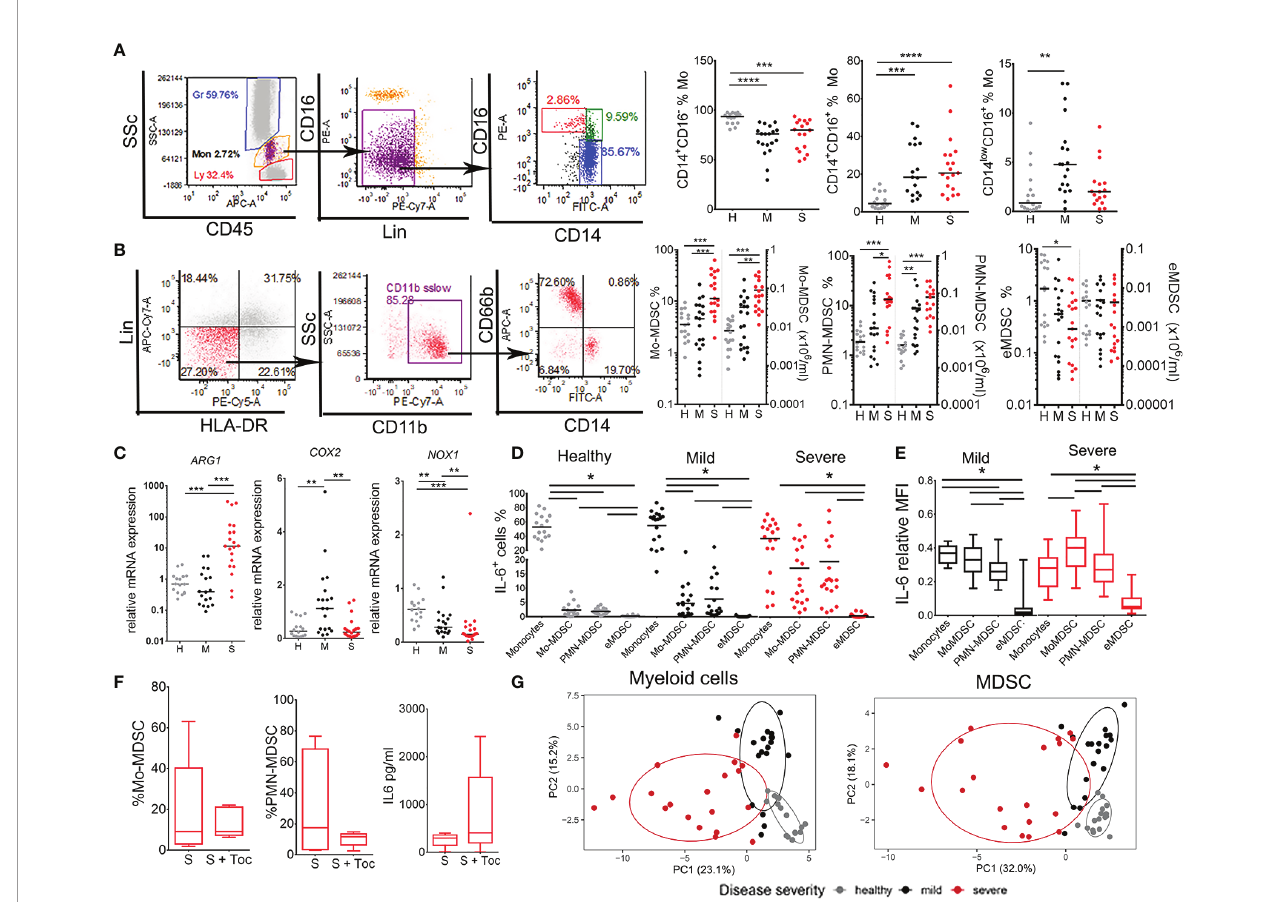
FIGURE 5 | Analysis of monocytes and myeloid derived suppressor cells (MDSC) subsets in coronavirus disease (COVID)-19 patients and healthy donors. (A) Classical (CD14 + CD16 - ), in fl ammatory (CD14 + CD16 + ), and transitory (CD14 low/- CD16 + ) monocytes (Mo) were identi fi ed in monocytes region (CD45 mid SSc mid ) after excluding doublets, CD16 hi granulocytes and lineage (lin) + (CD3 + CD7 + CD19 + CD56 + CD123 + Glycophorin A + ) cells. The summarized results are expressed as the proportion of cells in gated monocytes. (B) MDSC were gated from monocytes region of PBMC as Lin - (CD3 - CD7 - CD19 - CD56 - CD123 - Glycophorin A - ) HLA-DR low/- CD11b + cells expressing either CD66b/CD15 (PMN-MDSC), CD14 (Mo-MDSC) or neither CD66b/CD15 nor CD14 marker (eMDSC). The summarized results are expressed as the proportion of cells in monocytes region and the total number of cell/ml was calculated based on the hematological count of monocytes. (C) Relative mRNA expressions of ARG-1, COX2, and NOX1 were analyzed in PBMC. (D) The percentages of IL-6 + monocytes, Mo-MDSC, PMN-MDSC, and eMDSC (gated as in A, B ) are shown as the proportion of cells in monocytes region. (A – D) Summarized data were shown for 16 healthy donors (H), 19 mild (M), and 19 severe (S) patients. *p < 0.05, **p < 0.01, ***p < 0.005, ****p < 0.001, as indicated (Kruskal-Wallis test with Dunn ’ s post-test). (E) Relative expression of IL-6 in Monocytes and MDSC subsets of 19 mild and 19 severe patients was calculated by dividing mean fl uorescence intensity (MFI) of IL-6 in each cell subset and